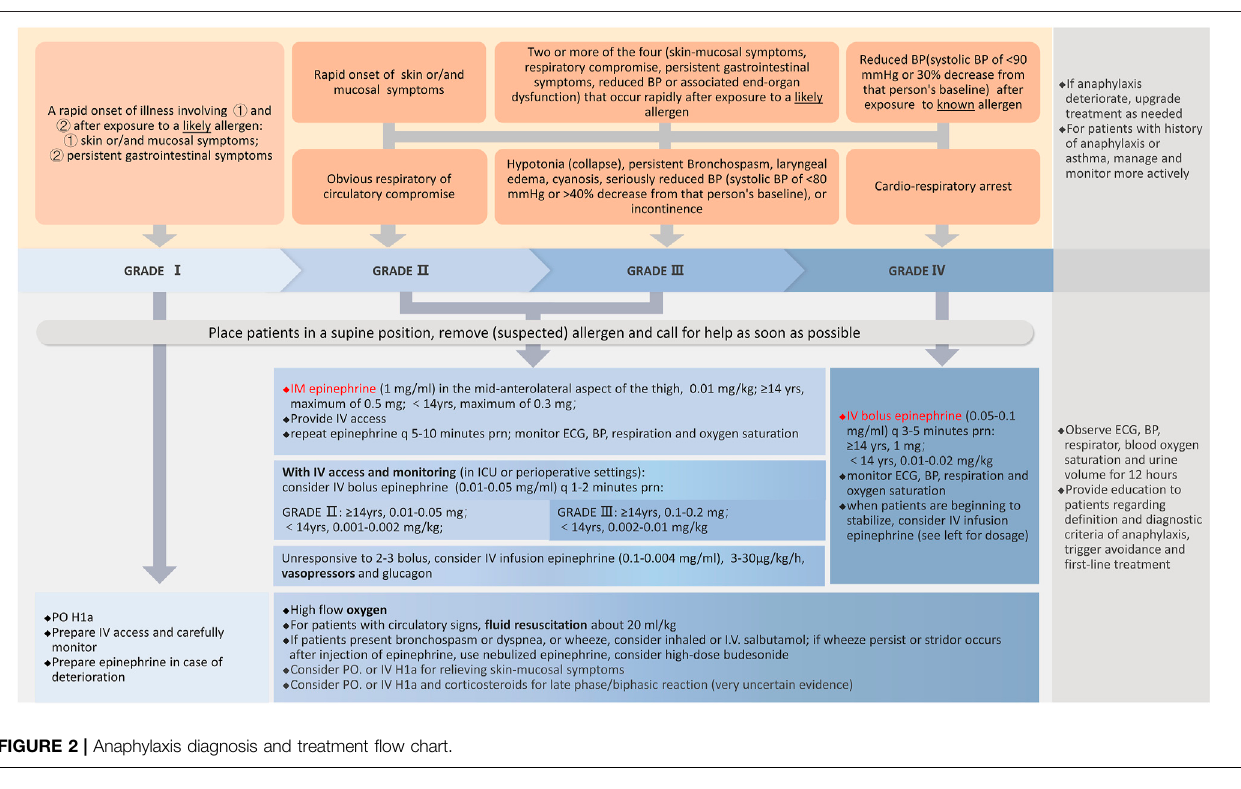
FIGURE 2 | Anaphylaxis diagnosis and treatment fl ow chart.